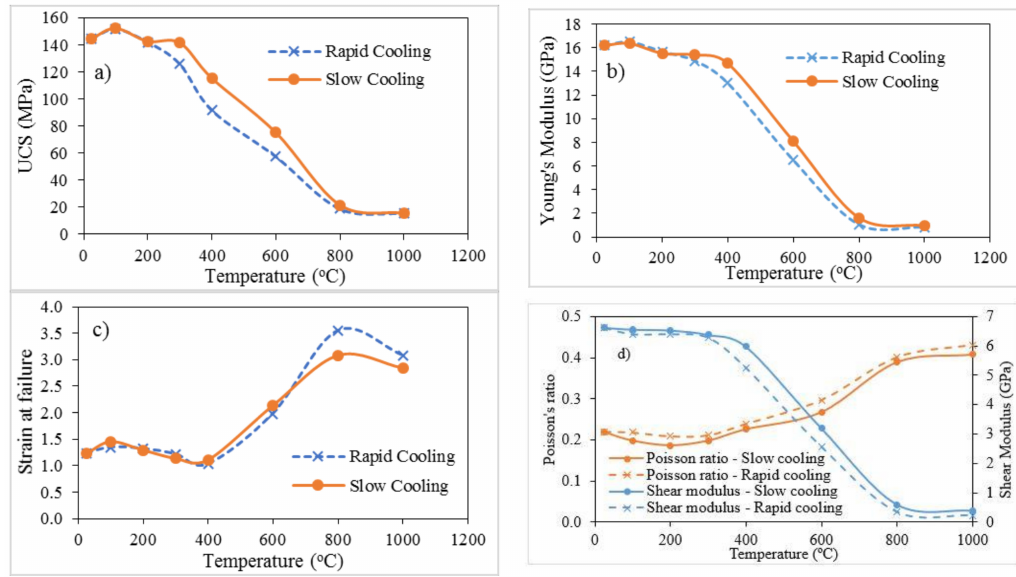
Figure 8. ( a ) Variation of UCS, ( b ) Young’s modulus, ( c ) strain at failure, ( d ) Poisson’s ratio and shear modulus with increasing pre-heated